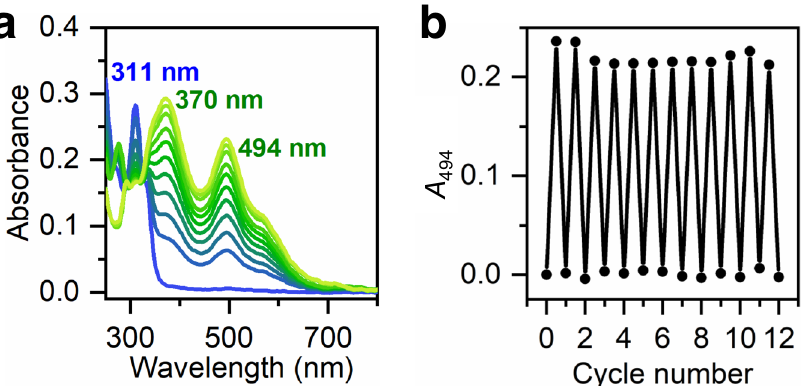
Fig. 5 | FeMETPsc1 redox characterization. a UV-Vis monitoring of Fe 2+ METPsc1 (blue trace) aerobic oxidation to Fe 3+ METPsc1 (lime trace). Spectra were acquired every 3min. 40 µ M FeMETPsc1, 20mM HEPES buffer 2mM TCEP, pH 7. b Redox cycling of FeMETPsc1 (40 µ M) in HEPES buffer (20mM) and TCEP 2mM, pH 7,